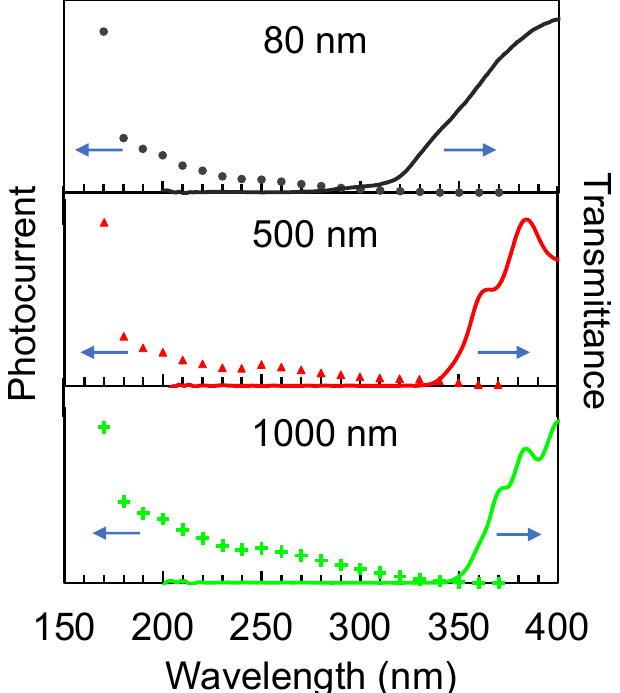
Figure 11. Wavelength response of the TiO 2 thin film detectors. The cut-off wavelength is shifted to longer